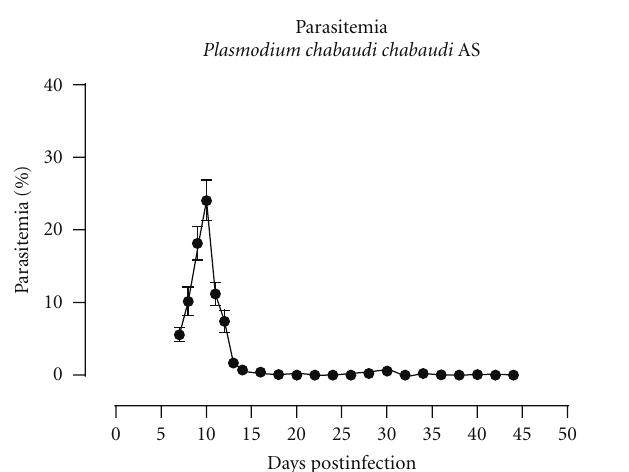
Figure 1: Parasitemia profile of Pc AS infection. Course of malaria infection in C57Bl/6 mice infected with blood stages of Pc AS. Data are representative of at least 3 independent experiments with n > 10 for each experiment (mean ± SEM).